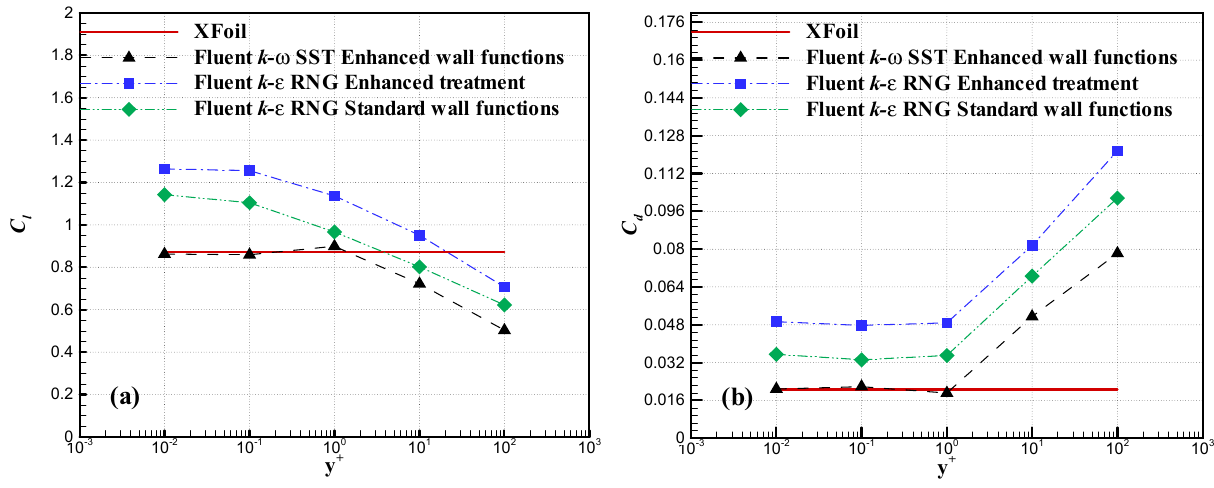
Figure 7. Lift and drag calculation check as a function of maximum y + at the first grid where α = 5° and Re = 1 × 10 5